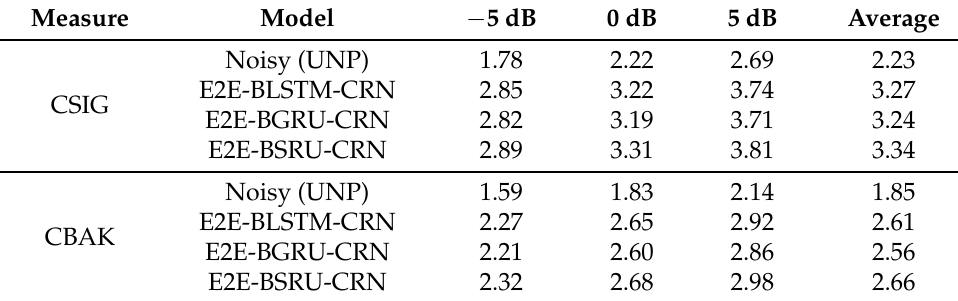
Figure 7. Average PESQ Scores (Seen Noisy Environments). Table 4. Average CSIG and CBAK scores in all Seen